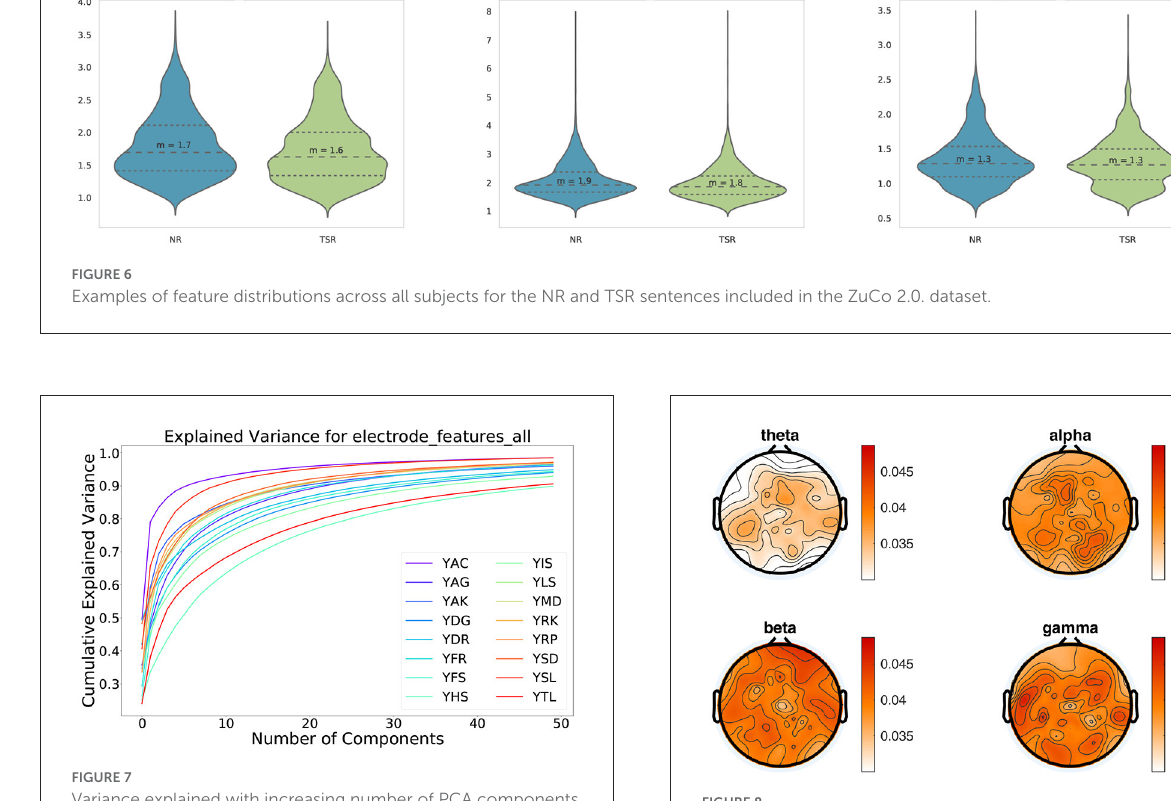
FIGURE8 Topographical distribution of electrode importance for the principle components, divided into the 4 different frequency bands. Electrode importance is calculated by determining the influence of each electrode on the principle components and weighting them by amount of explained